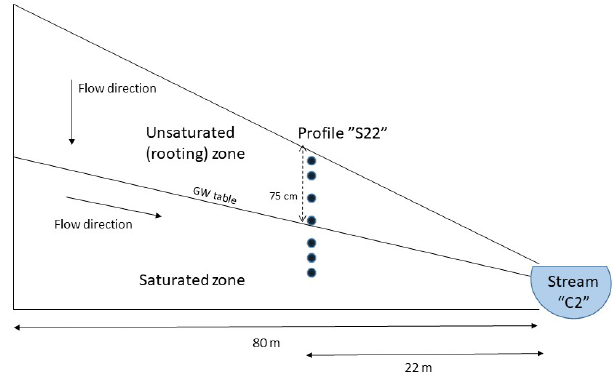
Figure 2. Schematic of the hillslope showing the sampled soil pro- file “S22” (not to scale). The boundary between the unsaturated and saturated zones is defined by the average groundwater